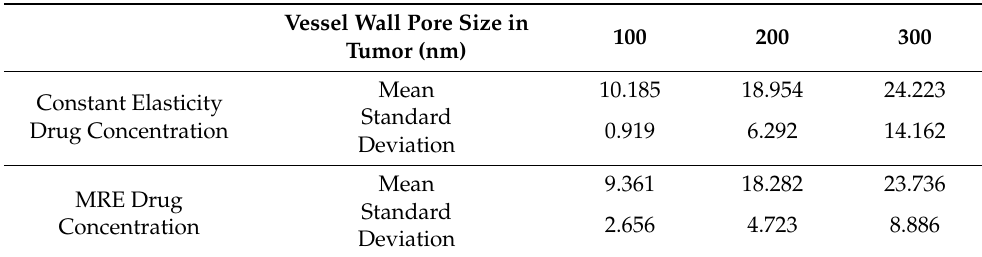
Figure 7. Drug concentration taken up by cancer cells for various wall pore sizes of the tumor vessels. A comparison between the isotropic-constant elastic properties case and the anisotropic-elastography case (patient 1) is shown. All results are displayed at day 43 of the simulation following a drug injection at day 41. The size of the drug is 2 nm. Table 2. Mean and standard deviation values of the spatial distribution of drug concentration in the tumor for the 6 cases considered in Figure